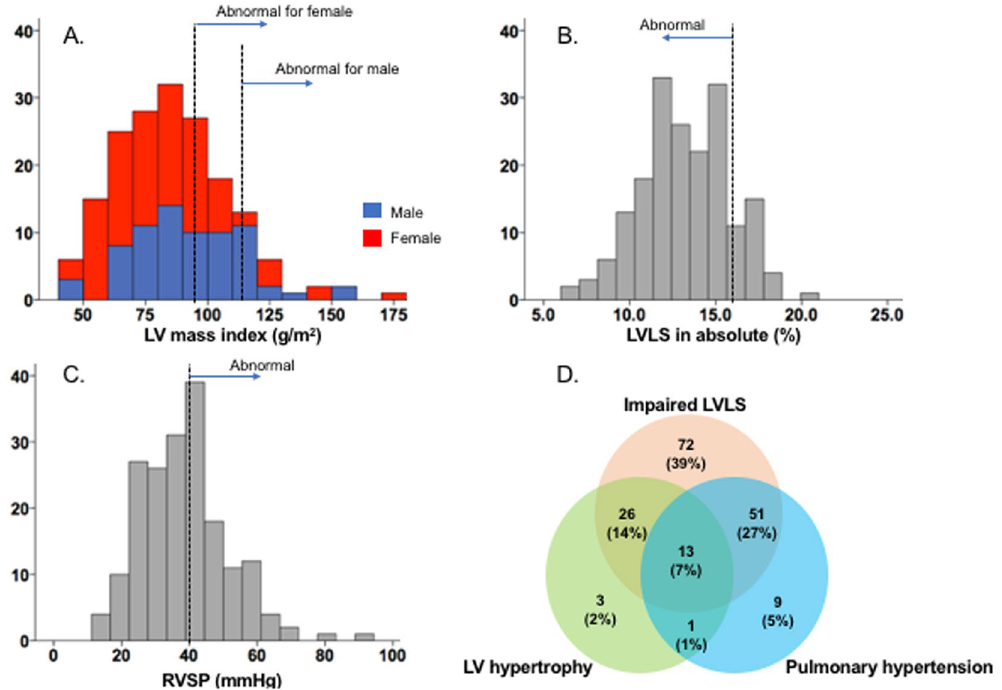
Figure 2. The prevalence of cardiac impairment in patients with HFPEF. The distribution of LV mass index ( A ), LVLS ( B ) and RVSP ( C ). The panel D presents the venn diagram demonstrating the overlap between LV hypertrophy (threshold of LV mass index 115 g/m 2 for male and 95 g/m 2 for female), impaired LVLS (threshold of LVLS − 16%), and pulmonary hypertension (threshold RVSP of 40 mmHg) features. LVLS, left ventricular longitudinal strain; RVSP, right ventricular systolic